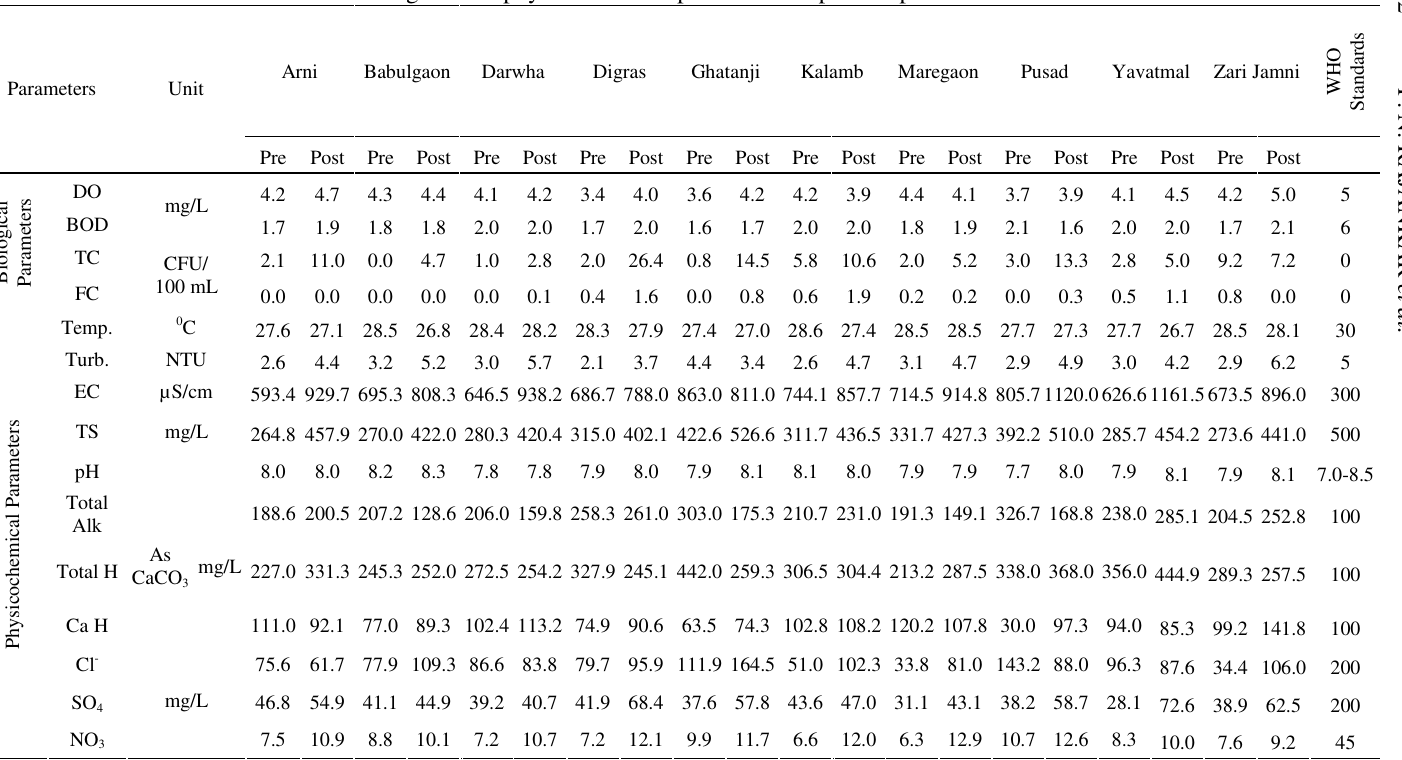
. Table 1. Biological and physicochemical parameters in pre and post monsoon